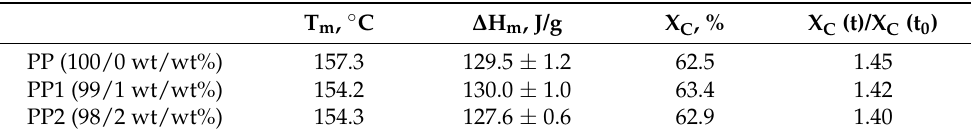
Figure 9. Relative elastic modulus as a function of the weathering time. Table 2. Melting temperature, enthalpy of fusion and crystallinity of polypropylene and polypropy- lene nanocomposites after 96 h of weathering